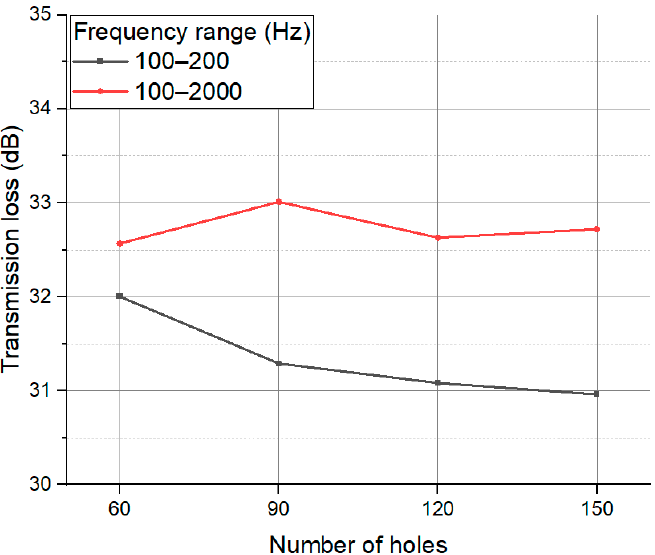
Figure 25. Average transmission loss according to the number of holes in the inner resonate type.